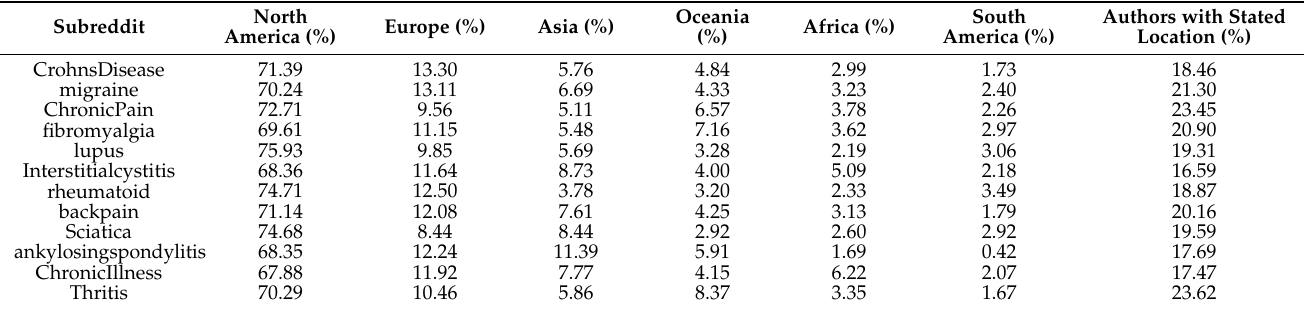
Table 4. Location distribution per